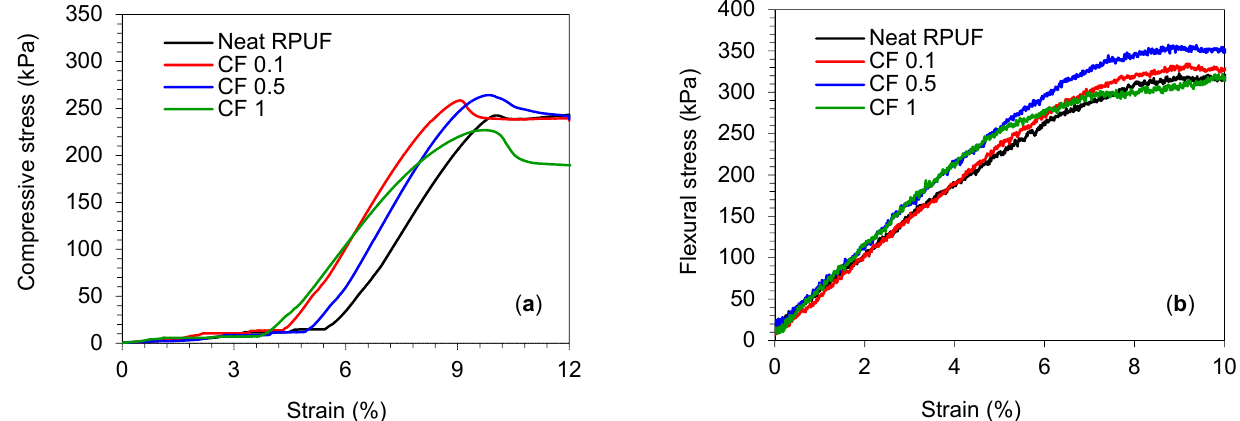
Figure 4. Median curves for compressive ( a ) and flexural ( b ) tests parallel to the rise direction of the studied RPUF com- posites.